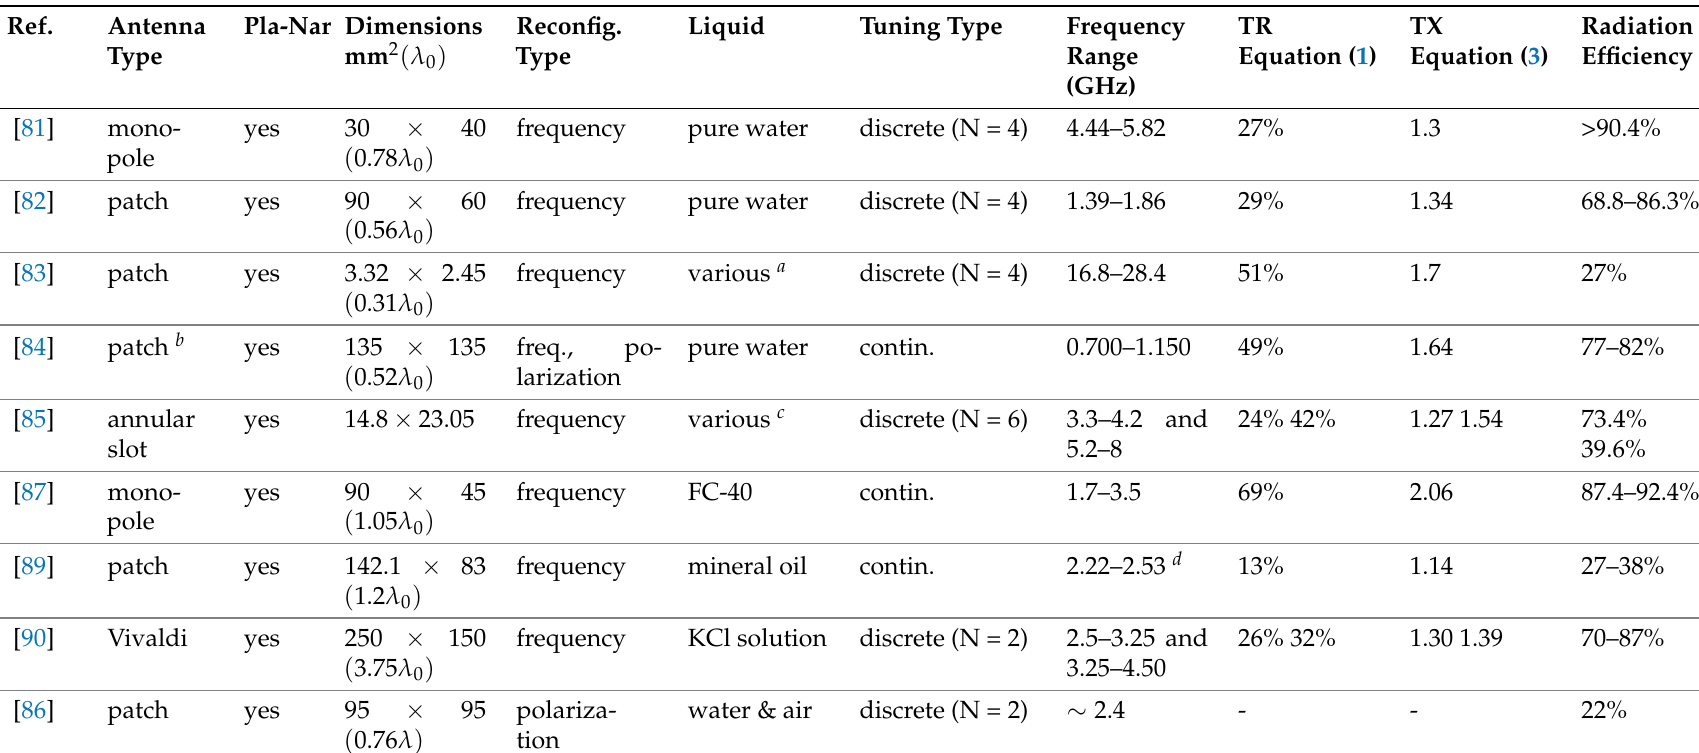
Table 5. Planar antennas with microfluidic